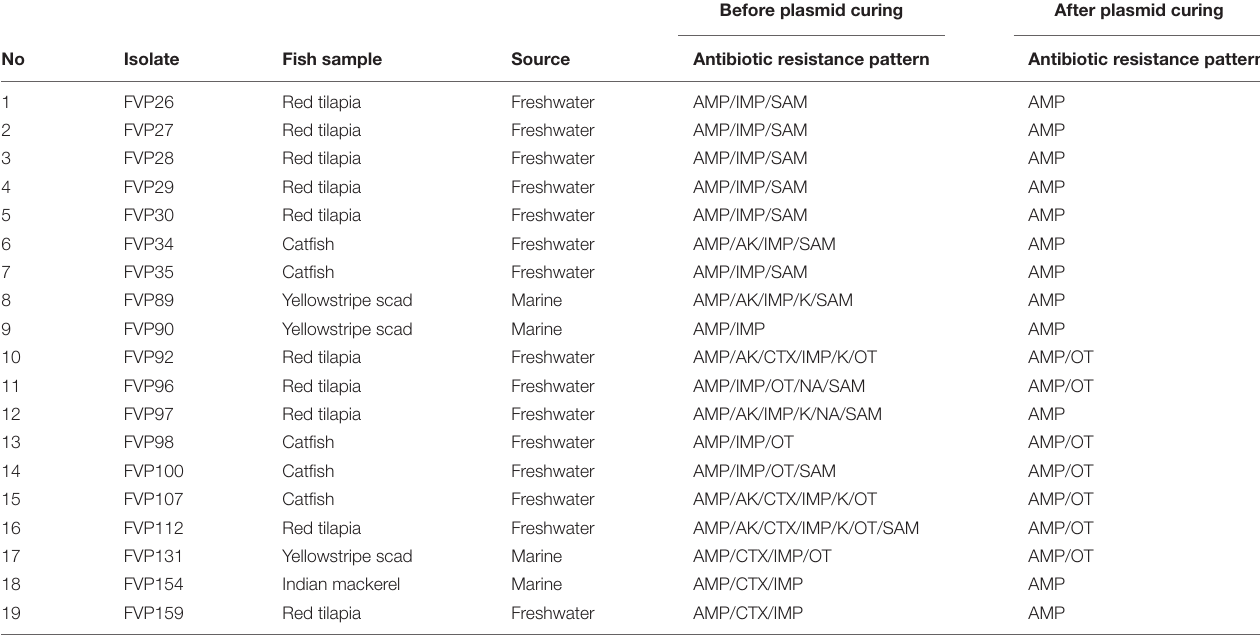
Before plasmid curing After plasmid